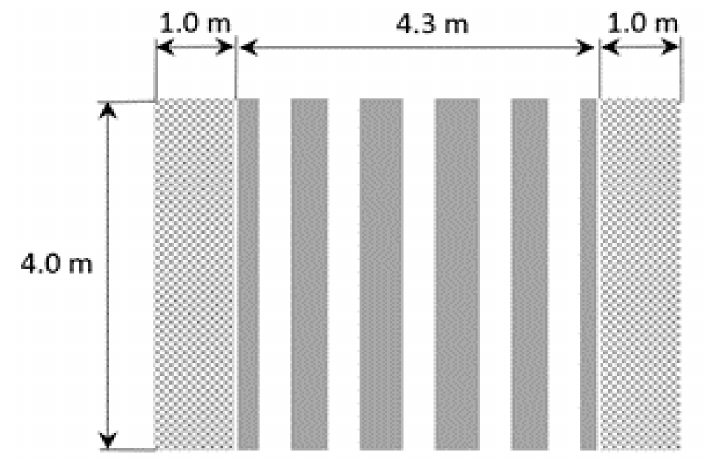
Figure A1. Basic dimensions of pedestrian crossing no. 1.